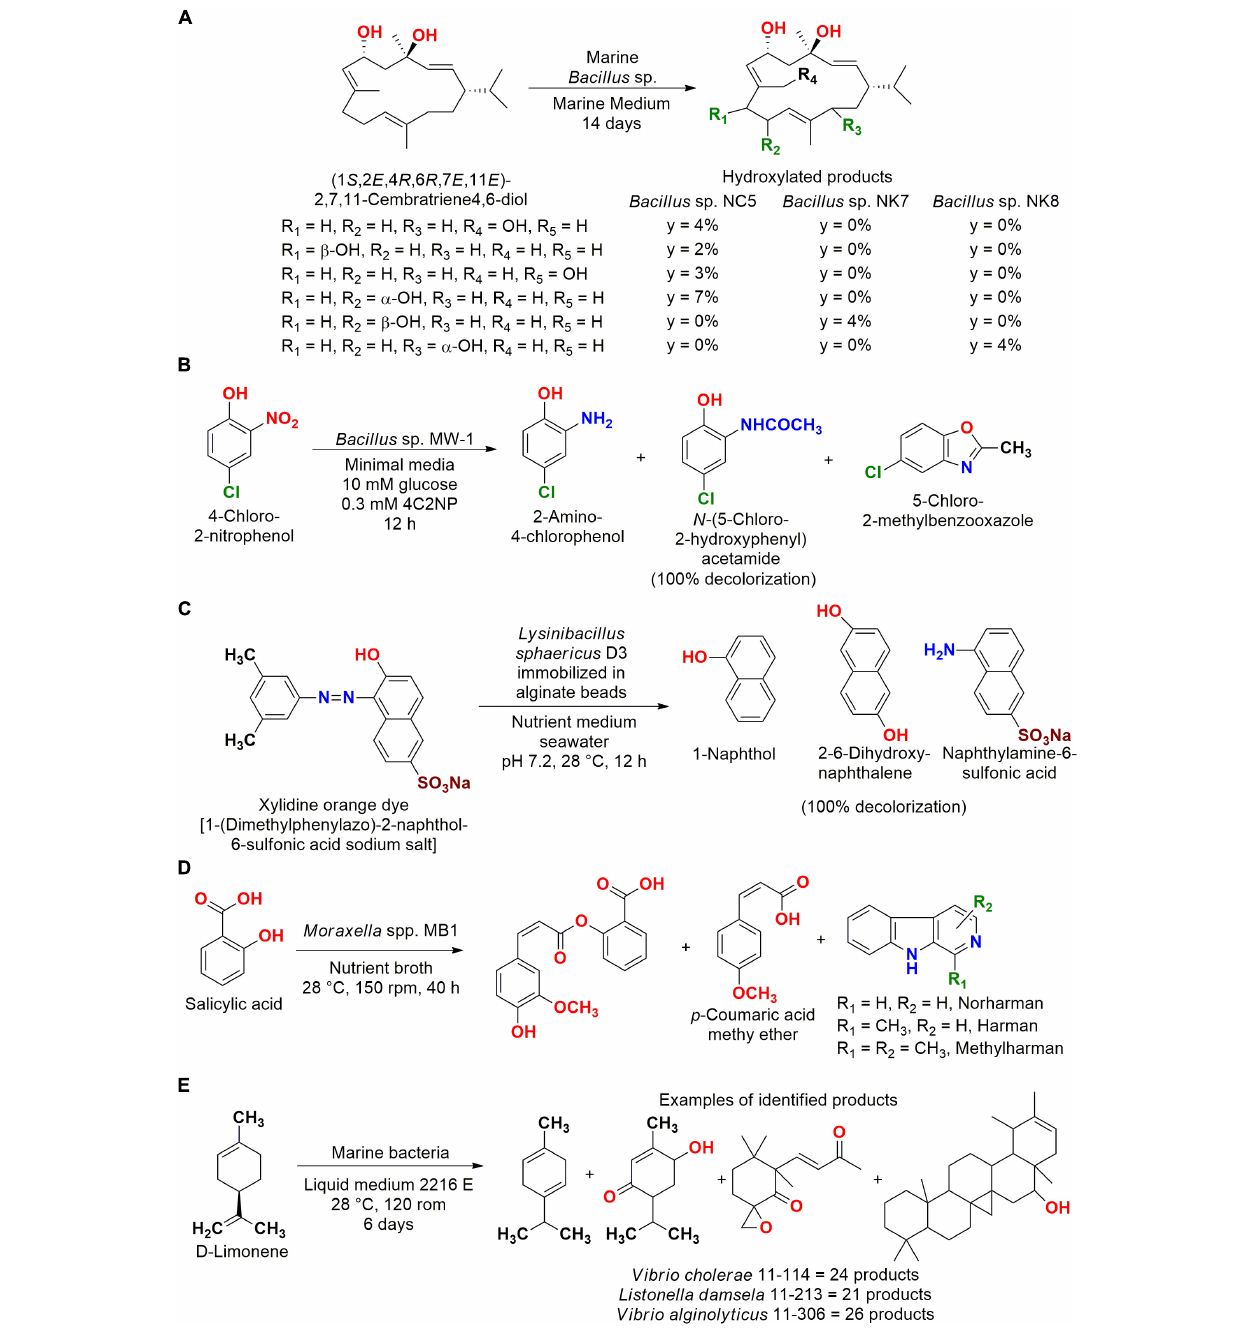
FIGURE 3 | (A) Biotransformation of (1 S ,2 E ,4 R ,6 R ,7 E ,11 E )-2,7,11-cembratriene-4,6-diol to hydroxylated products by Bacillus sp. strains (El Sayed et al., 2008). (B) Biotransformation of 4-chloro-2-nitrophenol to different products in sequential steps by Bacillus sp. MW-1 (Arora and Jain, 2012). (C) Decolorization of xylidine orange dye by L. sphaericus D3 (Devi et al., 2017). (D) Biotransformation of salicylic acid by Moraxella spp. MB1 (Wahidullah et al., 2013). (E) Biotransformation of D -limonene by Vibrio cholerae 11–114, Listonella damsela 11–213, and Vibrio alginolyticus 11–306 (Li et al.,